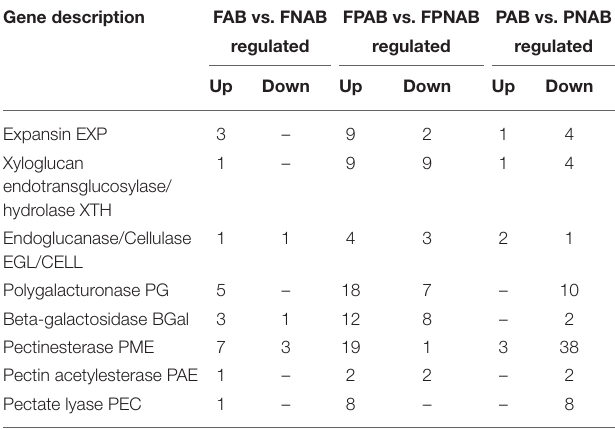
TABLE 2 | Differential expression patterns of cell wall-related genes in comparison of libraries FAB vs. FNAB, FPAB vs. FPNAB, and PAB vs.